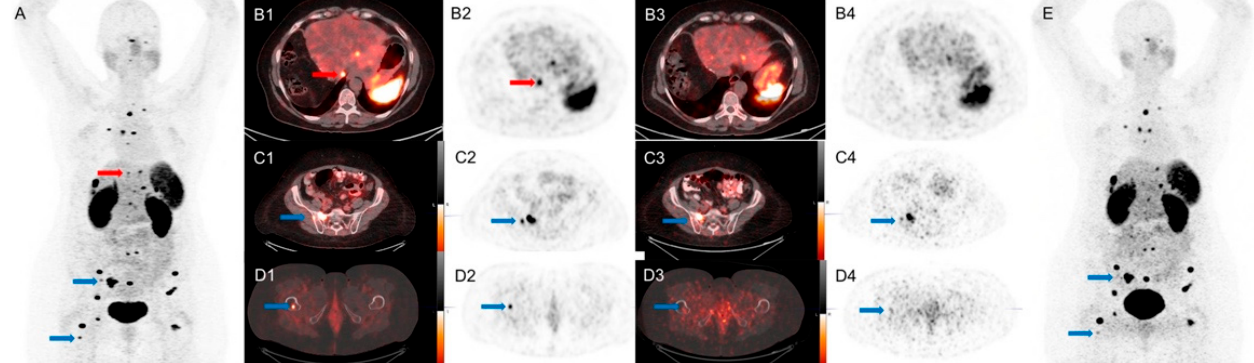
Figure 2. A 65-year-old woman with metastatic NET of unknown primary, referred for subsequent treatment strategy after chemotherapy. SiPM-based PET/CT was performed first at 72 min after injection of 4.2 mCi of 68 Ga-DOTA-TATE. Conventional PET/CT was performed second at 96 min after injection. Red arrows mark an additional lesion seen in the dome of the liver only on SiPM-based PET/CT ( A , B1 ), not on conventional PET/CT ( B3 , B4 , E ). Blue arrows mark bone lesions seen on conventional PET/CT ( C3 , C4 , D3 , D4 , E ) but more conspicuous on SiPM-based PET/CT ( A , C1 , C2 , D1 , D2 ). Table 2. Single organ analysis for patients who underwent SiPM PET/CT as first scan ( n = 52).